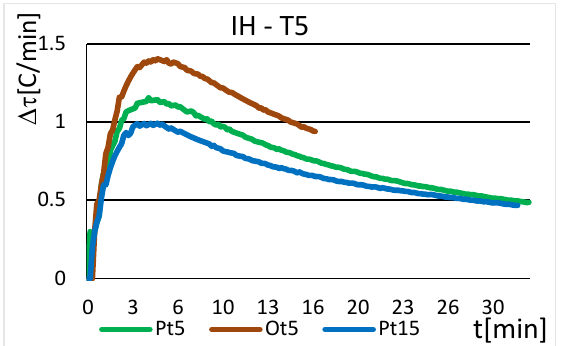
Figure 24. Dynamics of temperature increment across the slide plate from the side of stock-rail (T5) in induction heating IH for: Pt5 — switch-rail in contact with the stock-rail and the ambient temperature −5 ° C; Ot5 — the switch-rail moved away from the stock-rail and the ambient temperature −5 ° C; Pt15 — switch-rail in contact with the stock- rail and the ambient temperature −15 °C. Results of the climatic chamber testing also required analysis with regard to their uncertainty.